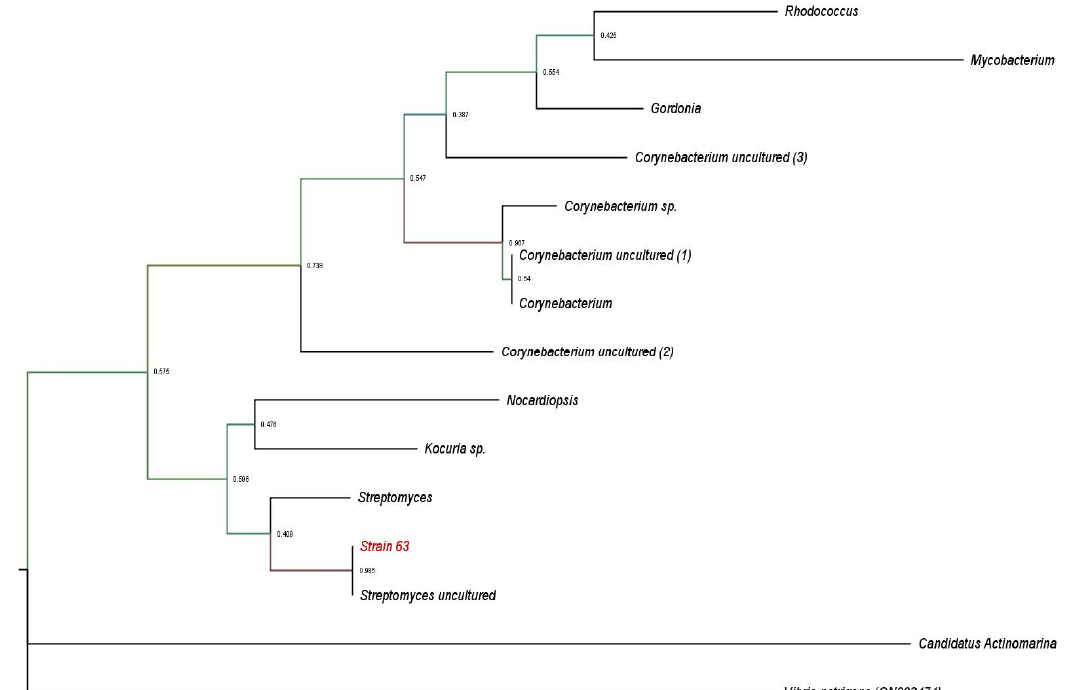
Figure 1. Molecularly rooted phylogenetic 16S rRNA gene tree analysis for strain 63 of Streptomyces sp. SCSIO 001680 by maximum likelihood method. The tree was rooted using 16S rRNA partial gene sequence of Vibrio natrigens - ON003437. The evolutionary history was inferred using the maximum likelihood method based on the Tamura3-parameter. Evolutionary analyses were conducted in MEGA 7 [41].